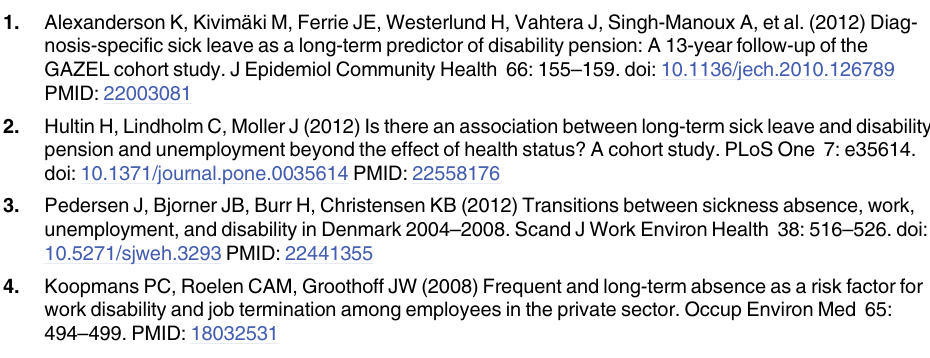
S1 Table. Univariate multinomial regression analyses with odds ratios and 95% confidence intervals for the association between categories of work ability with sickness absence among office workers (n = 1,331). (cid:4) p-value < 0.05; OR: odds ratio; 95% CI: 95% confidence interval; n: number of workers. a 0 sick days is reference category. S2 Table. Discriminative ability of the WAI in the prediction of different durations of sick- ness absence among office workers, subgroup analysis (n = 1,331). (cid:4) p-value < 0.05; WAI: Work ability index; ORC: ordinal c-index; 95% CI: 95% confidence interval.